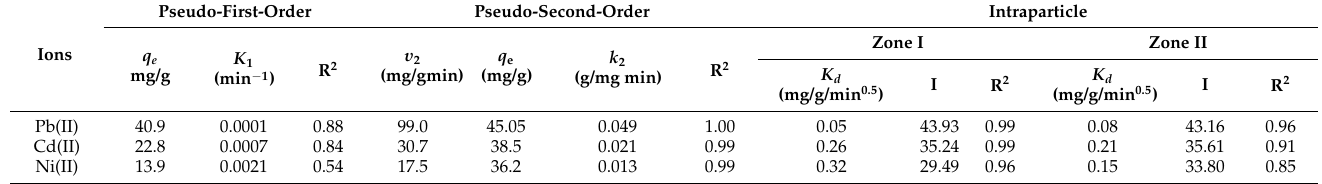
Table 4. Kinetic parameters of the Cd(II), Pb(II), and Ni(II) removal by S. cerevisiae biomass.